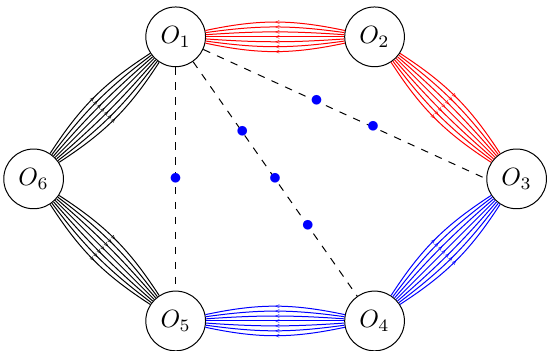
Figure 17 . The simplest six-point function. We make full use of the three complex scalars to adjust the external polarizations. For large charges this correlator is given by the product of two dodecagons. The dodecagon is obtained by gluing four hexagons including complicated multi- particle strings on zero bridges.